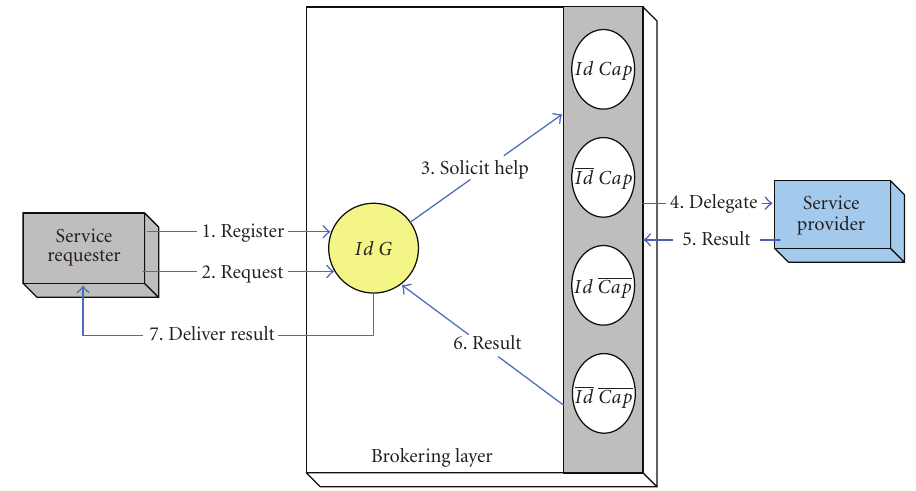
Figure 2: Interaction pattern for requesters revealing privacy attributes. Table 2: The brokering layer interaction categorized by the privacy concern of service